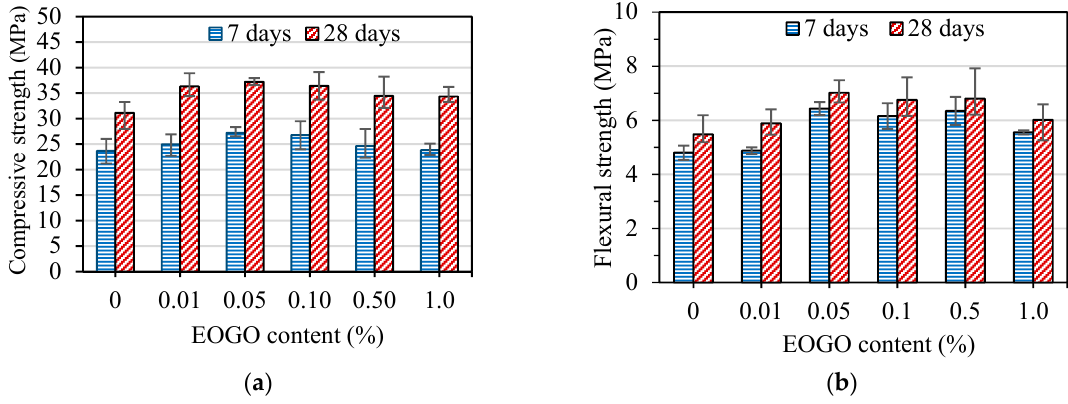
Figure 5. ( a ) Compressive strength and ( b ) flexural strength of EOGO-cement pastes with the dry-mix design method.